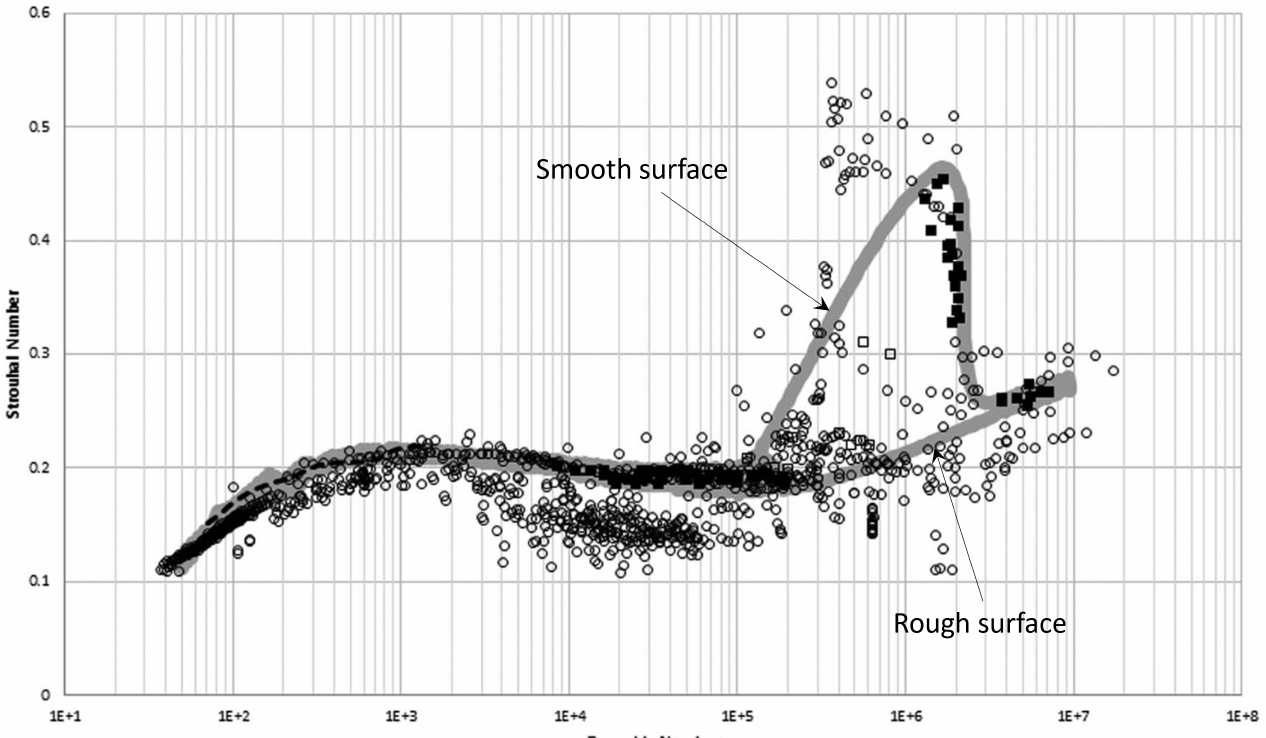
Figure 4. Strouhal number vs. Reynolds number. The original St versus Re curve as collated by [13] seen in the background in gray. The open circles denote the bulk of the data discussed and presented in [12,14] relating to Strouhal number, where the squares are some of the data, which were referenced by Lienhard in the development of the St versus Re curve. Figure from